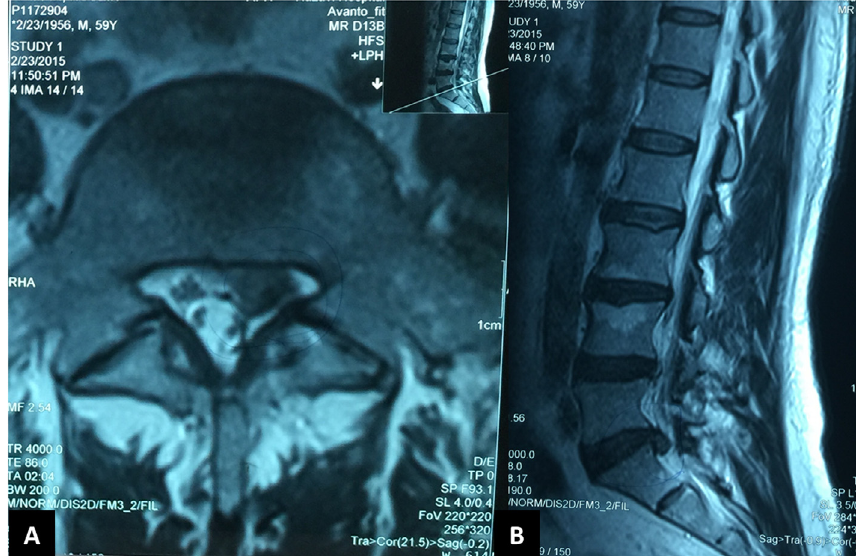
Figure 1. Axial (A) and sagittal (B) magnetic resonance imaging scans of the patient show degenerative disc disease in L3-L4, L4-l5, and L5-S1 levels, but left sided sequestrated disc herniation at L5-S1 was the main pathology consistent with the clinical